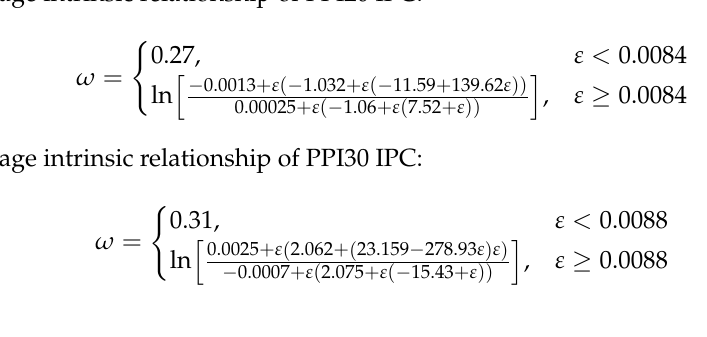
Figure 13. The damage intrinsic curves of PPI20 and PPI30 IPC.